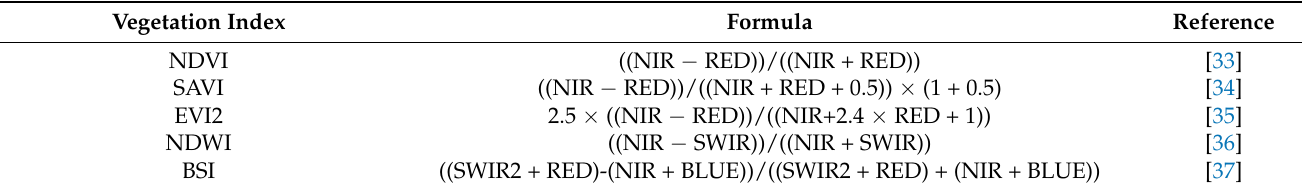
Table 3. Vegetation Indices and Spectral Ratios employed in the